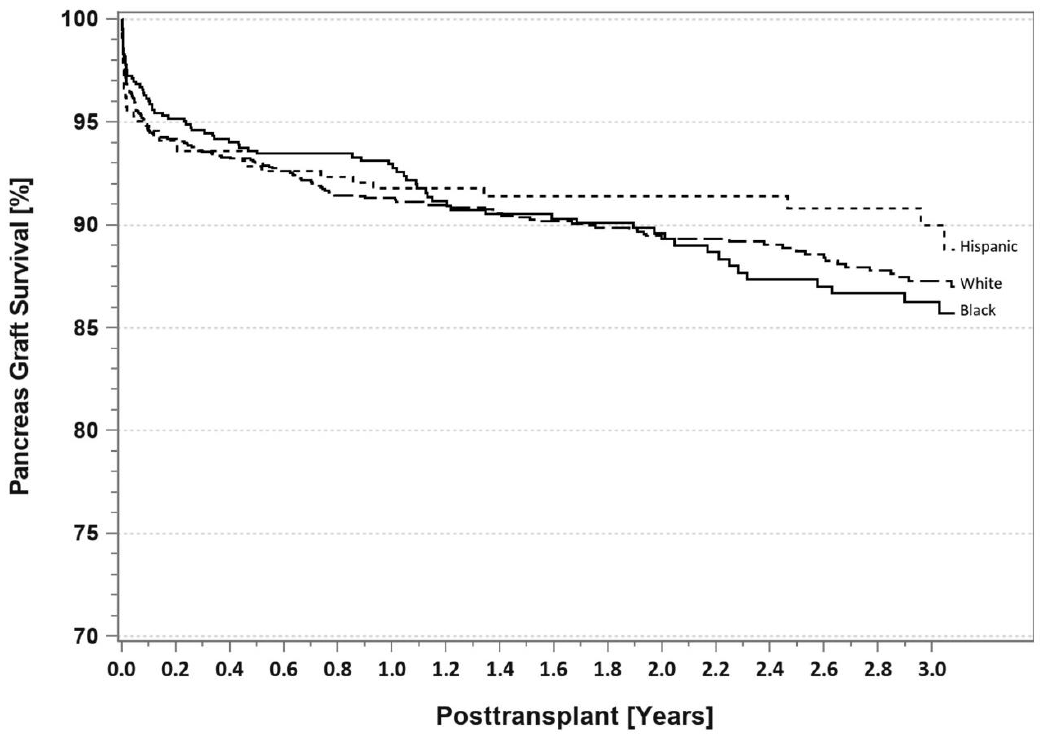
Figure 10. SPKT pancreas graft survival according to recipient race in patients identified as having